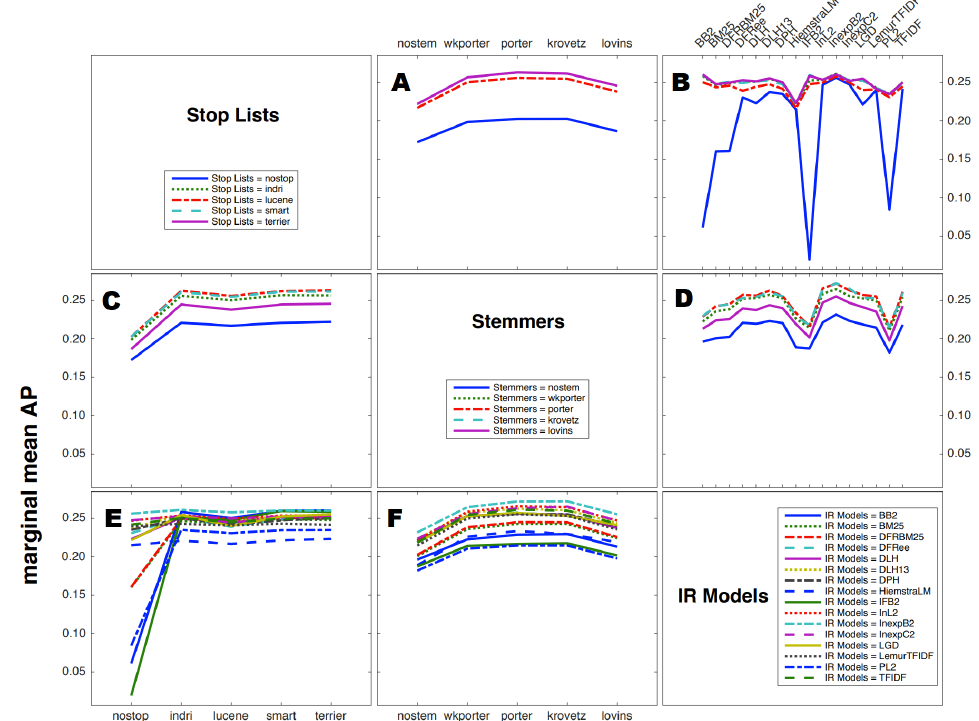
Figure 12. Interaction between component choices. The curves used in this representation are somehow misleading since the variables are not continuous but nevertheless can be understood, we thus kept the original Figures from [16]) where we added letters in each sub-figure for clarity. On the first row, the stop list effect is shown for different stemmers ( A ) and different weighting models ( B ). On the second row, the effect of stemmers is reported for different stop lists ( C ) and different weighting models ( D ). On the latest row, the weighting model effect is reported, for different stop lists ( E ) and different stemmers ( F ). Figure adapted with permission from [16], Copyright 2016, Nicola Ferro et